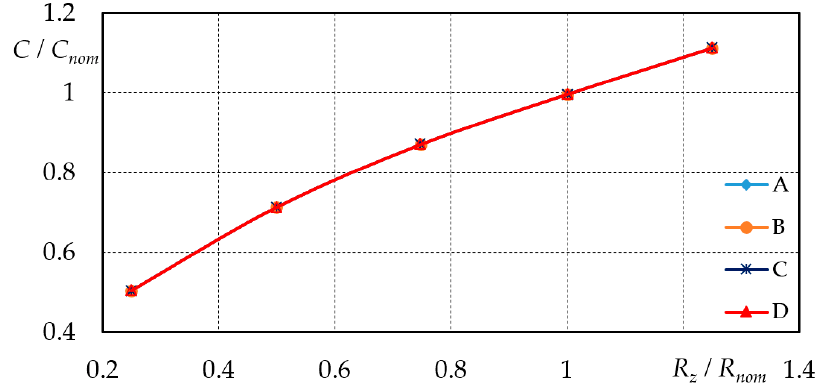
Figure 9. Dependence of relative stiffness of the tread part with a pattern on the relative radial load for different tires (compressed prism model; marking according to Table 2).